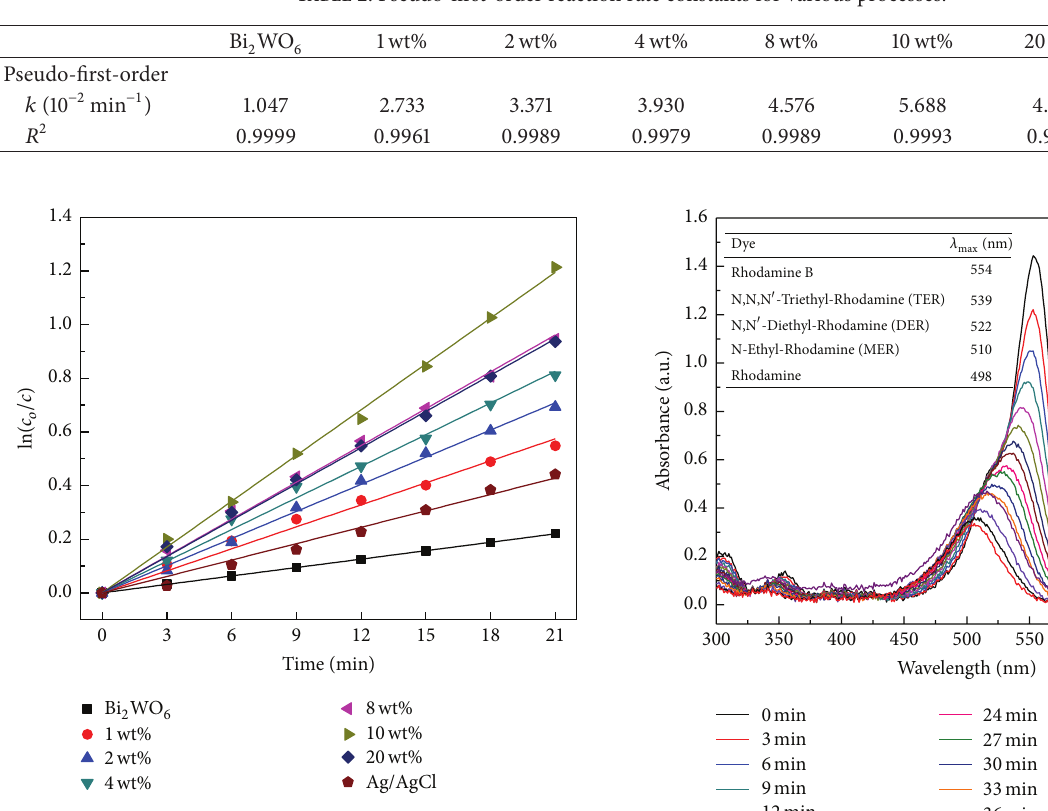
Figure 9: Photocatalytic kinetics of each process.